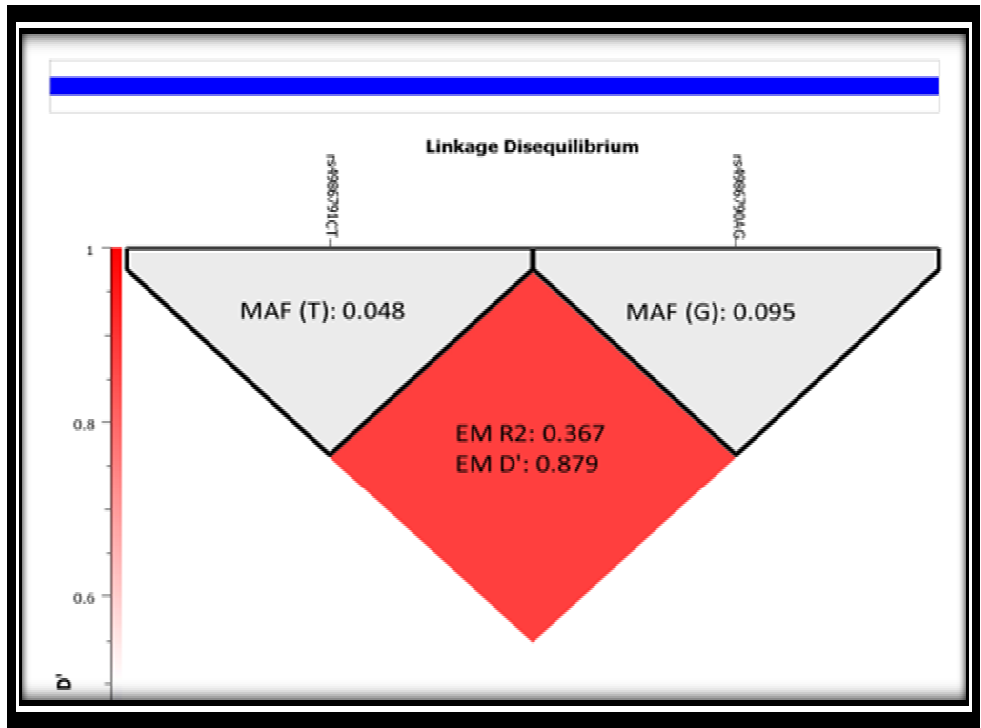
Figure 2. Linkage Disequilibrium (LD) of rs4986791 (Thr399Ile) and rs4986790 (Asp299Gly) in all study subjects. The red diamond represents pairwise LD expressed as EM R2 and EM D values between rs4986791 and rs4986790, respectively. The grey triangles represent minor allele frequency (MAF) of each genetic variant in all study subjects.